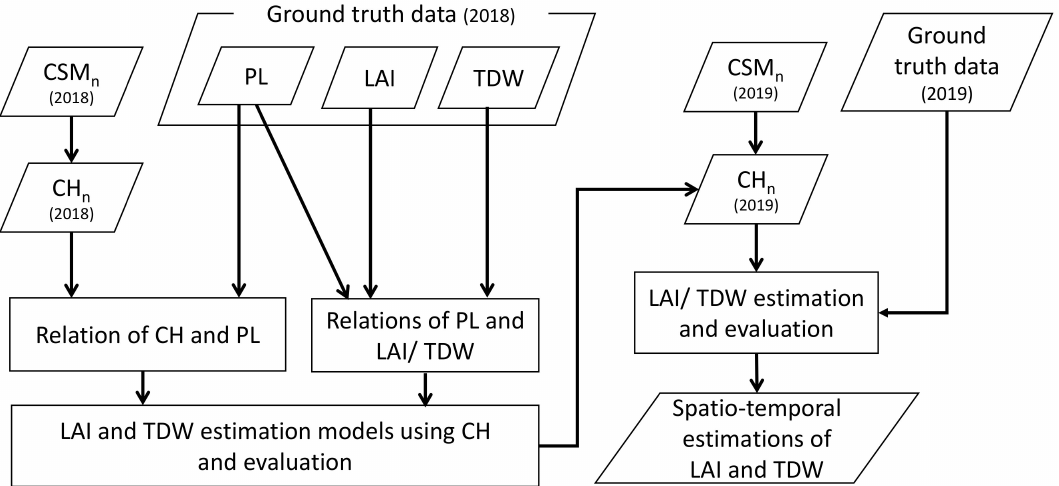
Figure 4. Procedures of spatio-temporal estimations using canopy surface